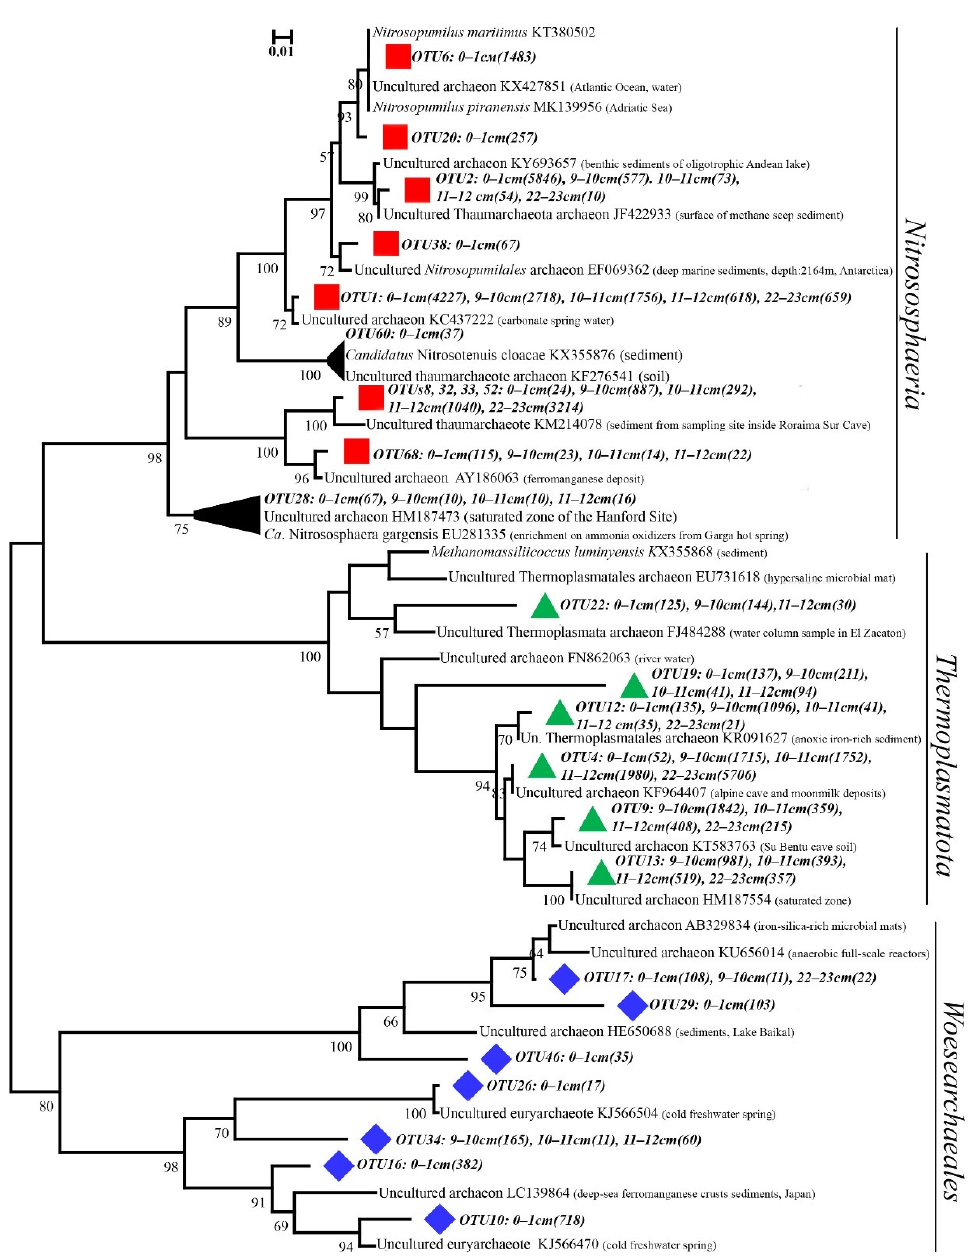
Figure 8. NJ phylogenetic tree of dominant phyla based on 16S rRNA gene sequences of class Nitrososphaeria ( Crenarchaeota ), order Woesearchaeales and phylum Thermaplasmatota . Bootstrap values > 50% (of 100 replicates) are shown in front of respective nodes, and the scale bar represents 5% sequence divergence. OTUs described in this work are represented by squares, lozenges, and triangles.